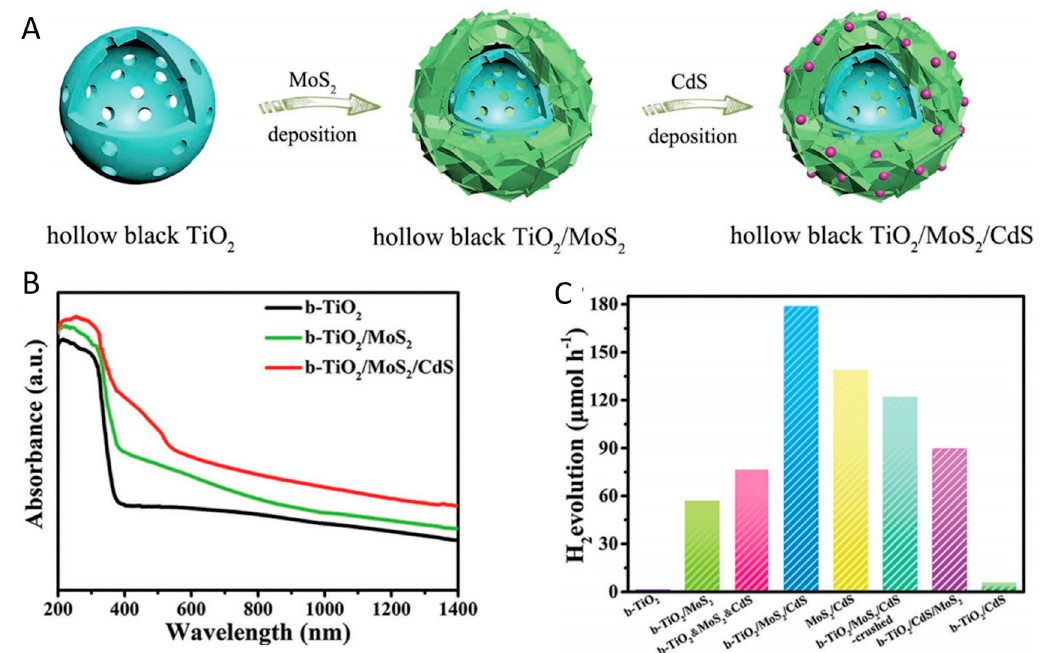
Figure 15. ( A ) Schematic illustration for the formation of TiO 2 /MoS 2 /CdS, ( B ) UV-vis spectra, ( C ) photocatalytic H 2 evolution measurements. Reprinted with permission for ref. [122]. Copyright 2018, Wiley-VCH.